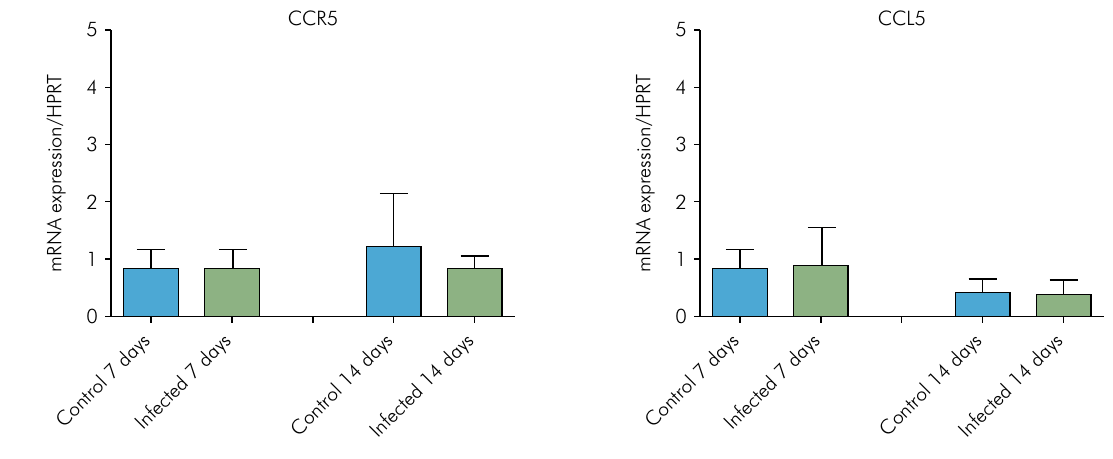
Figure 1. mRNA expression of the chemokines CCR5 and CCL5 analysed by real-time PCR in response to experimental infection in GF mice by microbial bi-association of E. faecalis , and F. nucleatum . The relative mRNA expression levels were quantified compared with those of the internal control (HPRT). The data were expressed as the mean ± standard error of two independent experiments with six mice per group. The bars represent the mean values of the samples recovered from the axenic mice, and the error bars represent the standard errors of the